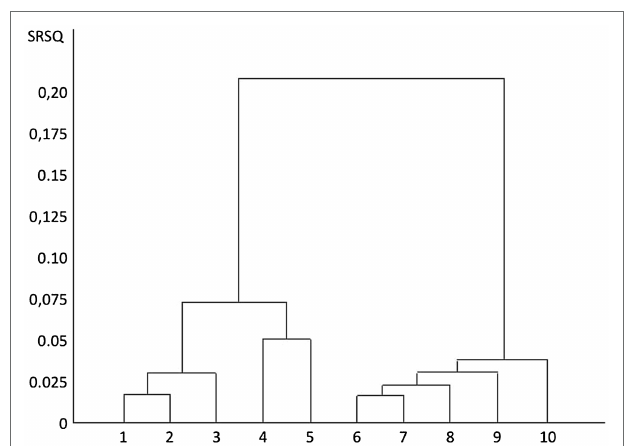
FIGURE 1 | Cluster dendrogram. The dendrogram is based on the participants’ preferences for different qualities in nature. Y -axis semipartial R-square; X -axis clustered preferences. The higher up in the dendrogram: a cluster, or a couple of clusters, has separated from the others, the more they differ from the others. (1) The Death, (2) The Storm, (3) The Adventurer, (4) The Sun, (5) The Moon, (6) The Path, (7) The Eternity, (8) The Fertility, (9) The Guardian, and (10) The Garden of